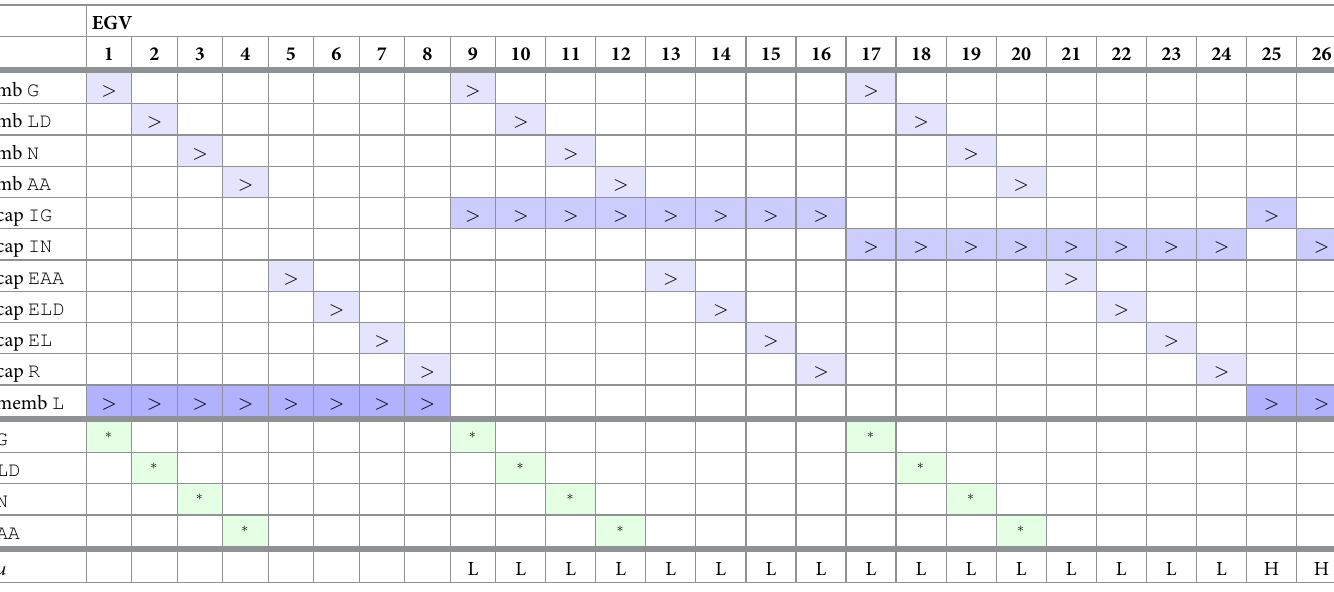
Table 3. EGVs for the small model of a self-fabricating cell.